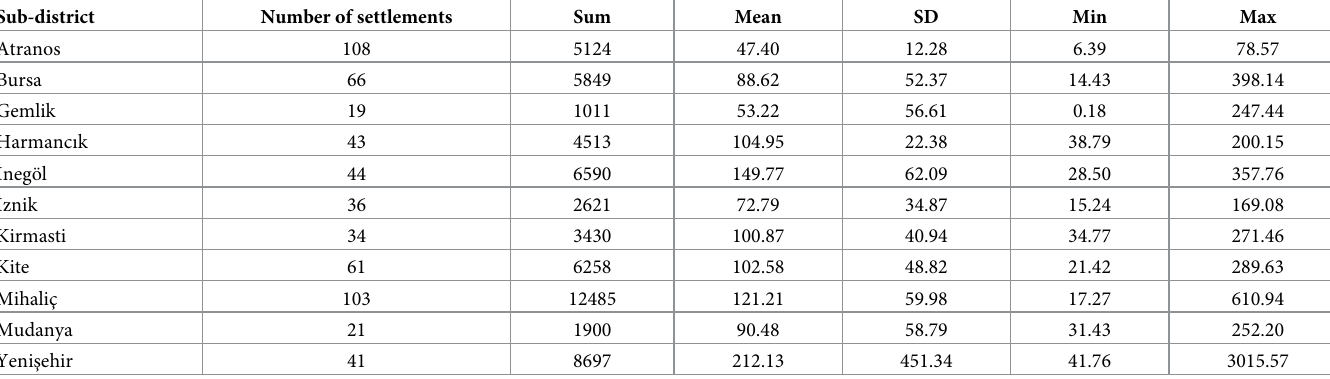
Table 7. Summary statistics of estimated and observed agricultural land area (in ha) from Model